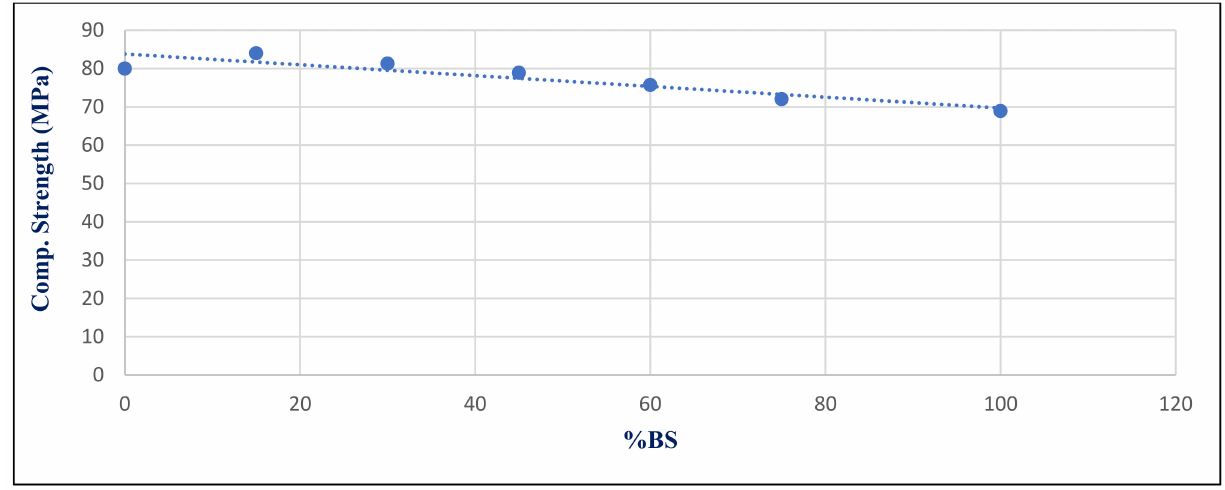
Figure 30. Correlation relation between compressive strength at a 750 ◦ C fire exposure and %BS for group Z at day